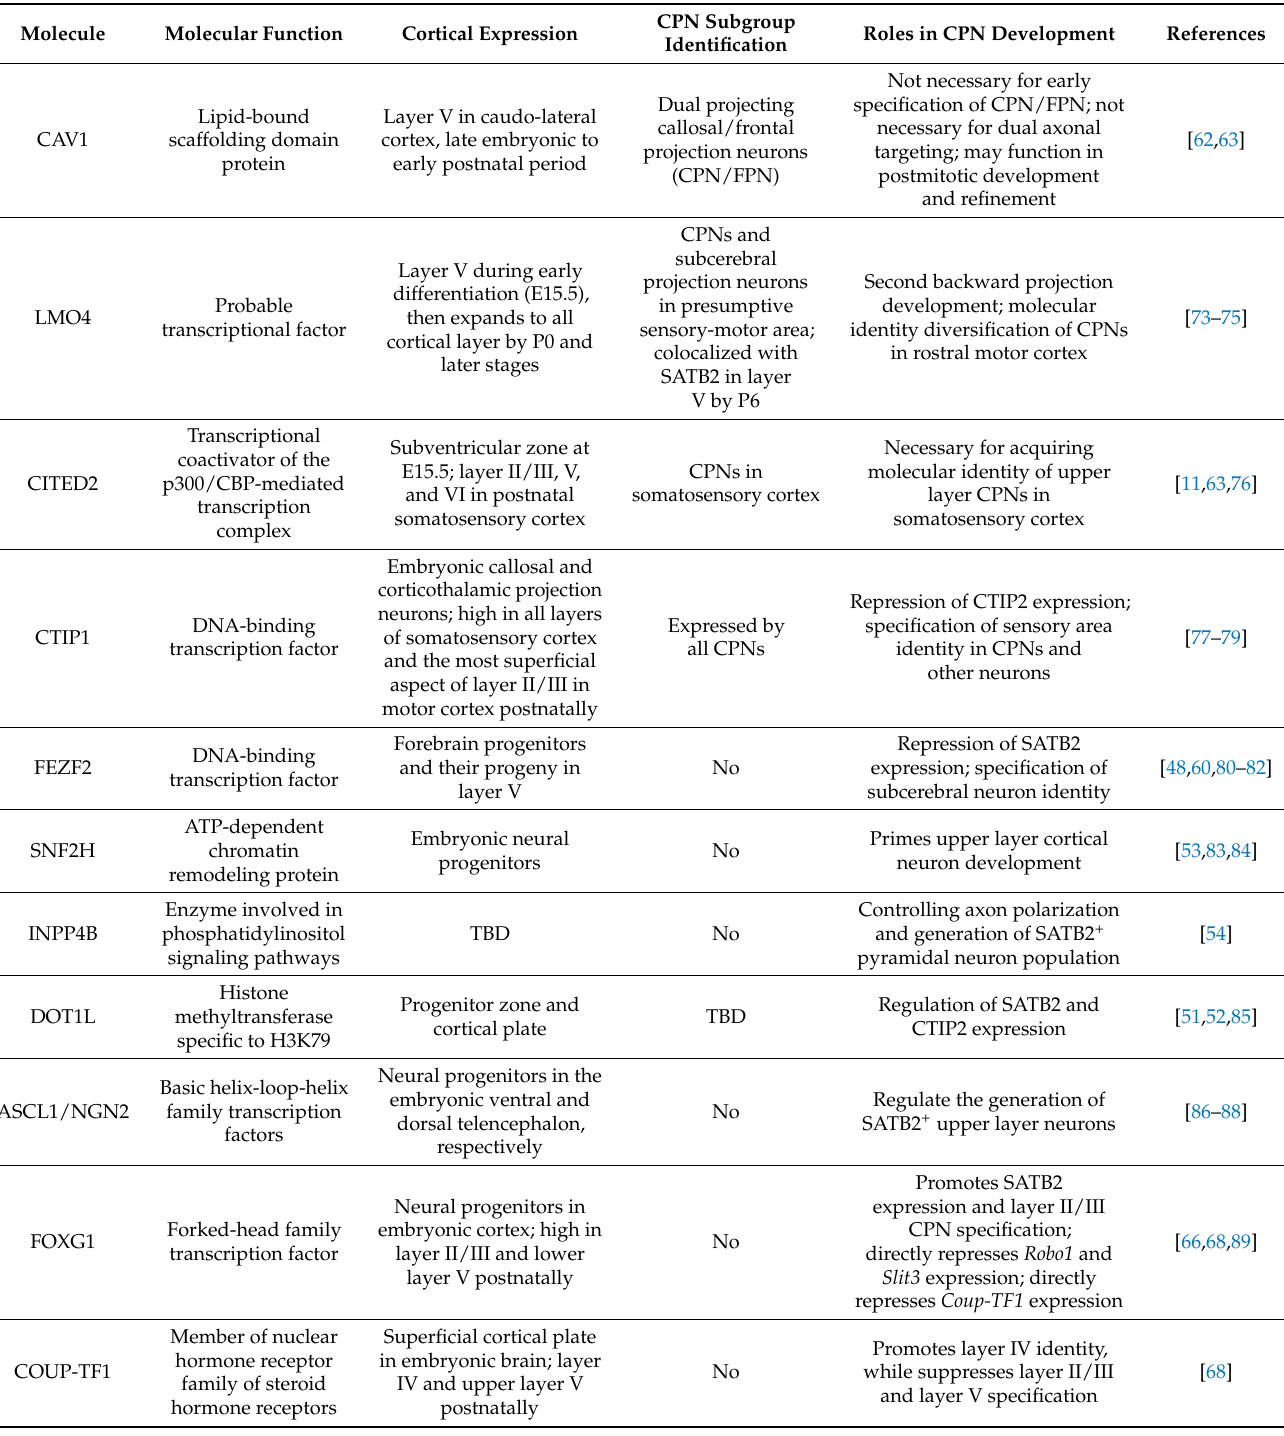
Table 1. List of newly reported molecules that play roles in callosal projection neuron (CPN) specification.